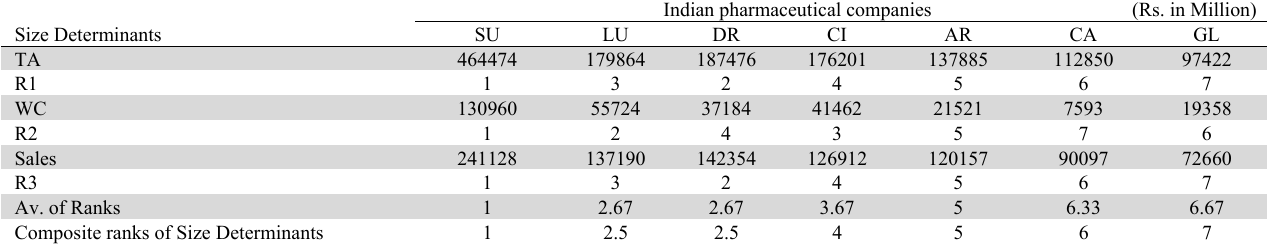
Size & Rankings of the selected leading Indian pharmaceutical companies (2013-18) Size